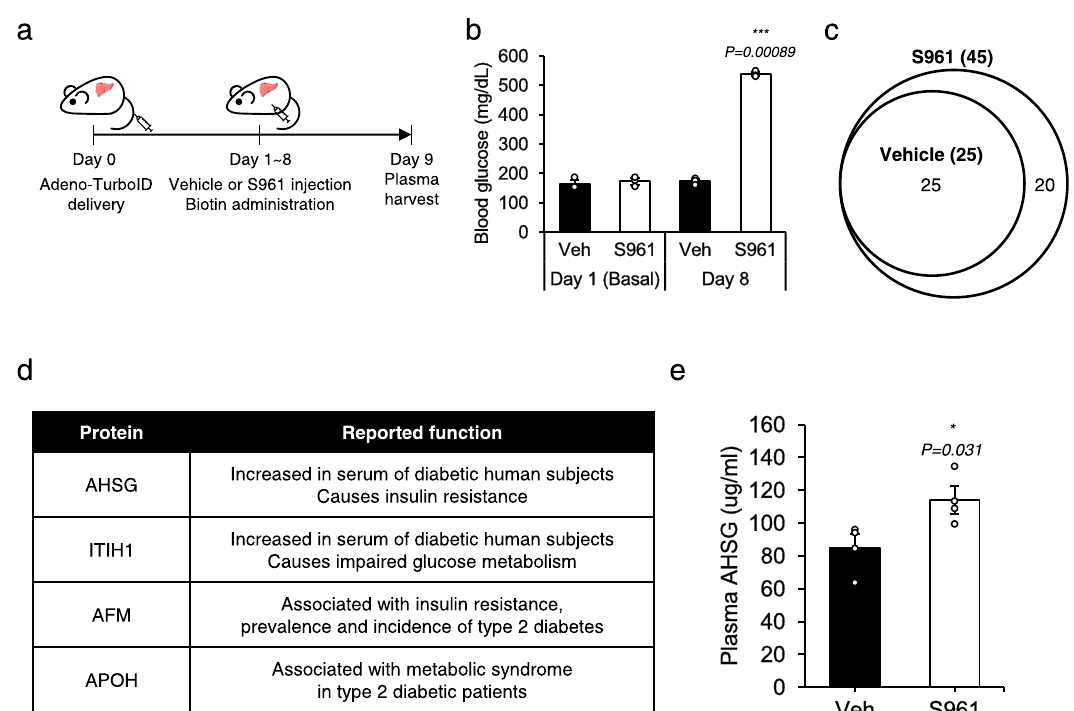
Fig. 4 Application of i SLET to pathophysiological mouse models. a Experimental scheme for adenoviral expression of Sec61b-V5-TurboID and biotin labeling in the S961-induced insulin resistance model. b Blood glucose levels in Vehicle or S961 treated mice. n = 3 per group. A two-tailed Student ’ s t-test was used to compare groups. p- value for Day 8 group is 0.00089. c Venn diagram depicting biotinylated secretory proteins detected in the blood plasma of Vehicle or S961 treated liver i SLET mice from biological triplicate analysis (see Supplementary Fig. 7 for details of analysis). d Representative candidates related to insulin resistance detected in this study. AHSG, Alpha-2-HS-glycoprotein; ITIH1, Inter-alpha-trypsin inhibitor heavy chain H1; AFM, Afamin; APOH, Beta-2-glycoprotein 1. e Plasma AHSG levels of Vehicle or S961 treated mice. n = 4 per group. A two-tailed Student ’ s t-test was used to compare groups. p- value is 0.031. All data expressed as mean ±